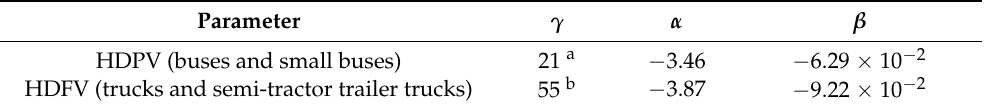
Table 2. Parameters of the Gompertz function.